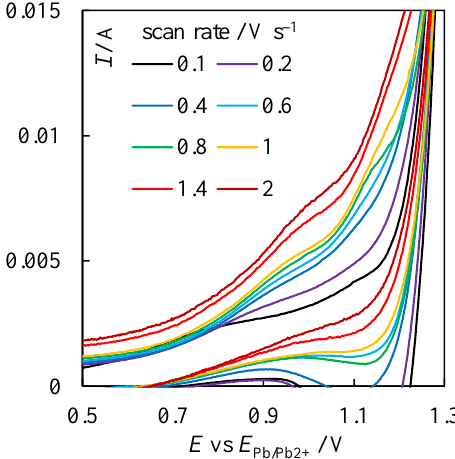
Figure 10. CVs in the PbCl 2 – 0.044 wt% PbO melt at a potential sweep rate from 0.1 to 2 V s −1 and a temperature of 520 ° C.